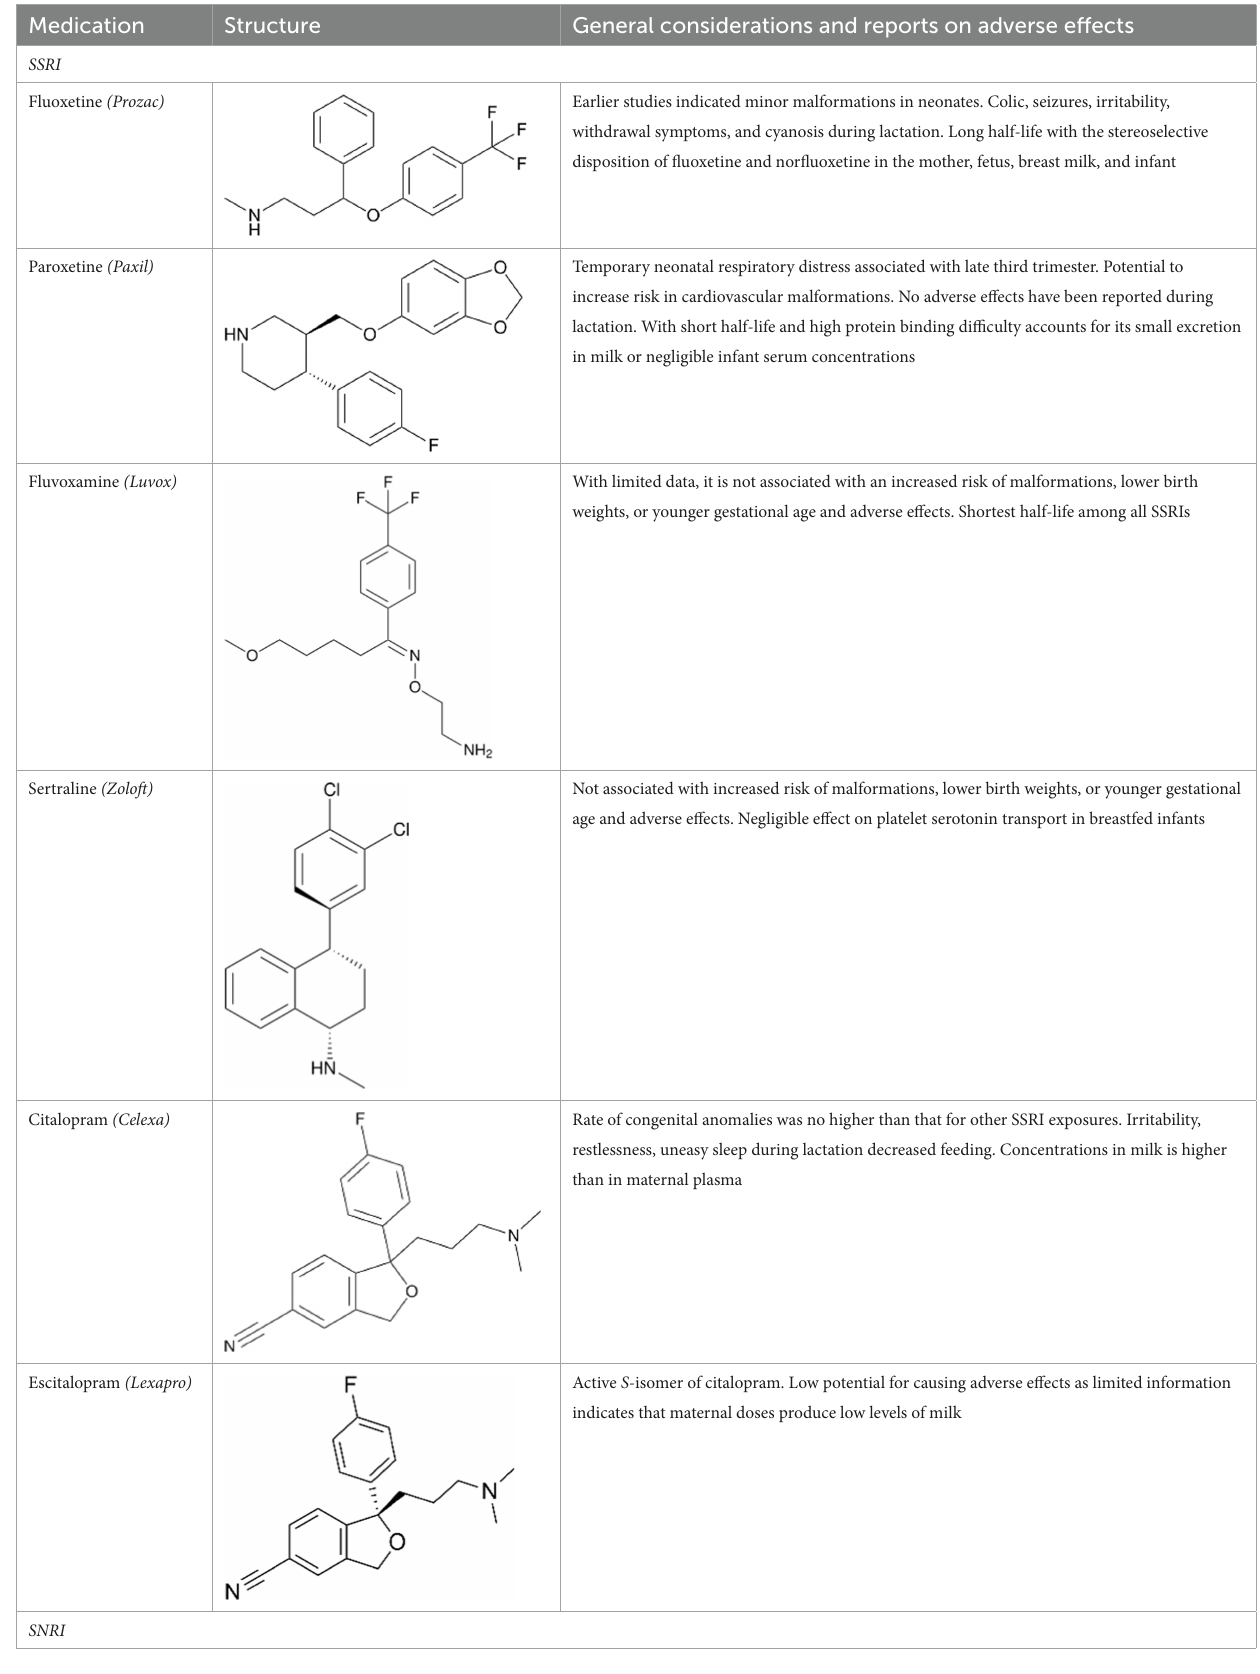
TABLE 1 General considerations and reports on antidepressant-induced adverse effects during pregnancy and